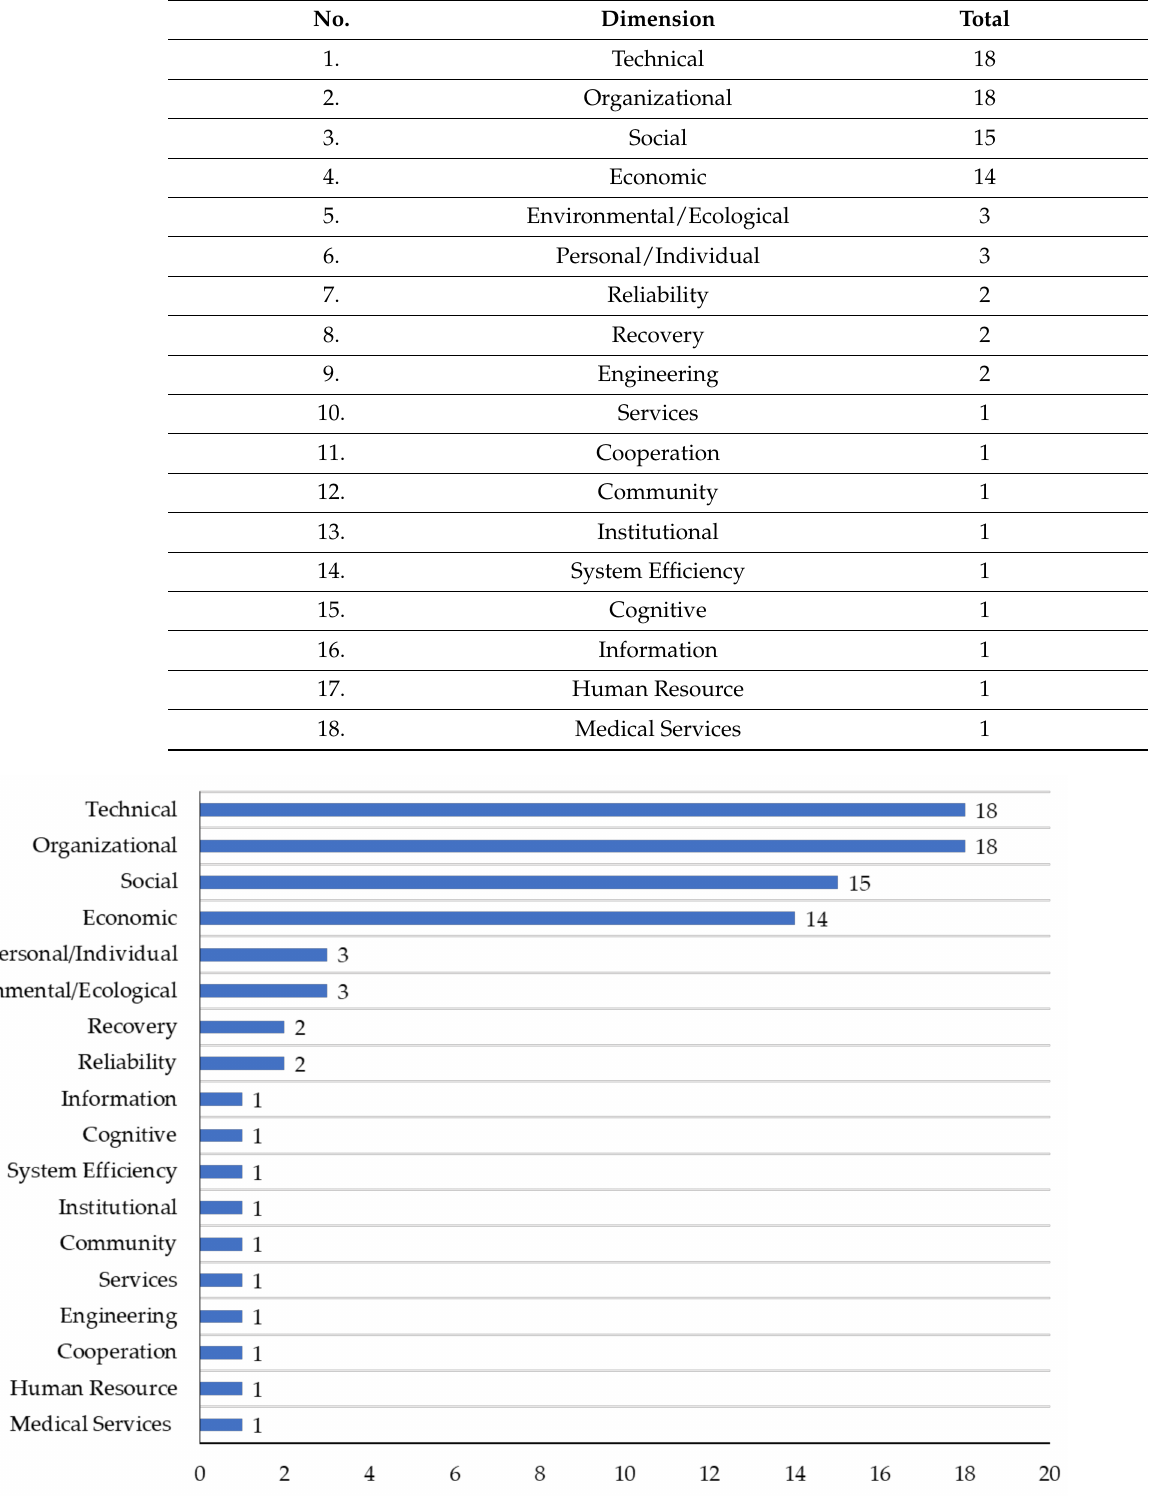
Table 2. Dimensions of the identified resilience assessment frameworks of CIs for analysis.